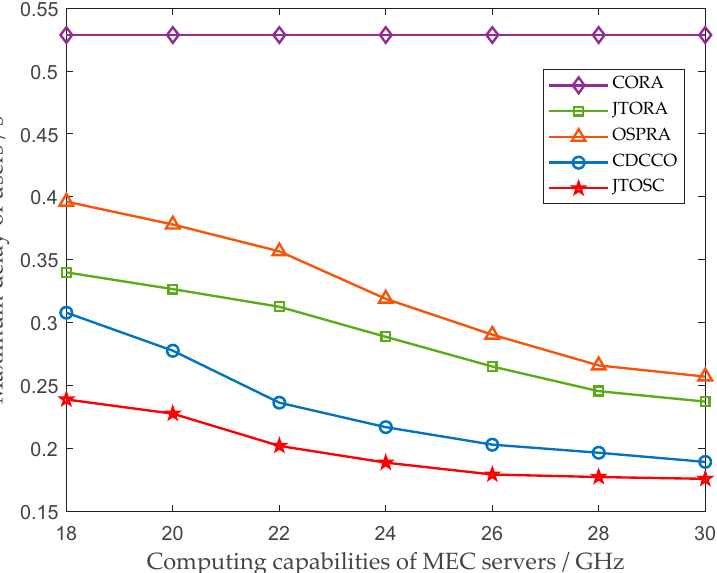
Figure 4. The impact of the computing capabilities of MEC servers on the maximum delay of users.